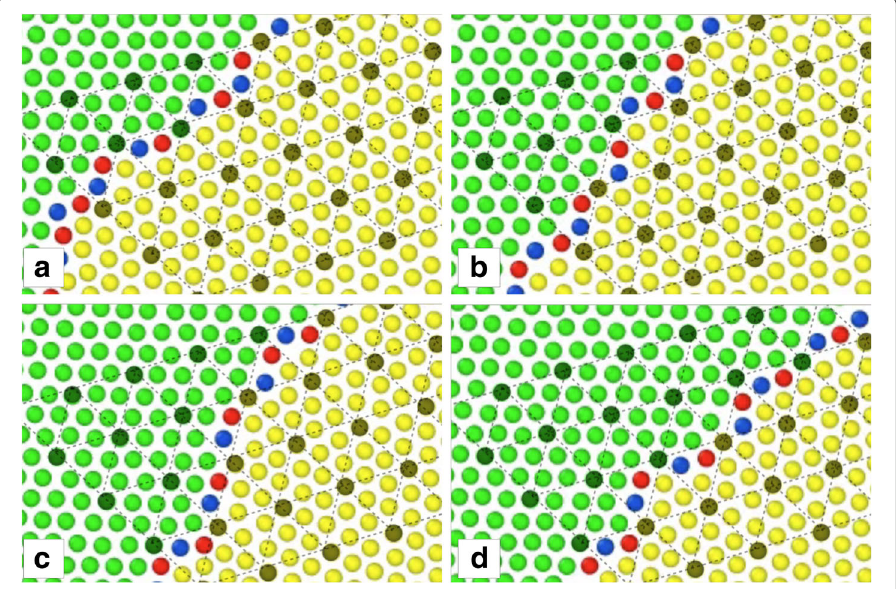
Fig. 16 a - d 5-7 defects walk during grain shrinkage for θ 0 = 21.8 ◦ . Atoms on the (cid:18) 7 coincidence site lattice are shown in black, the coincidence sites grid in dotted